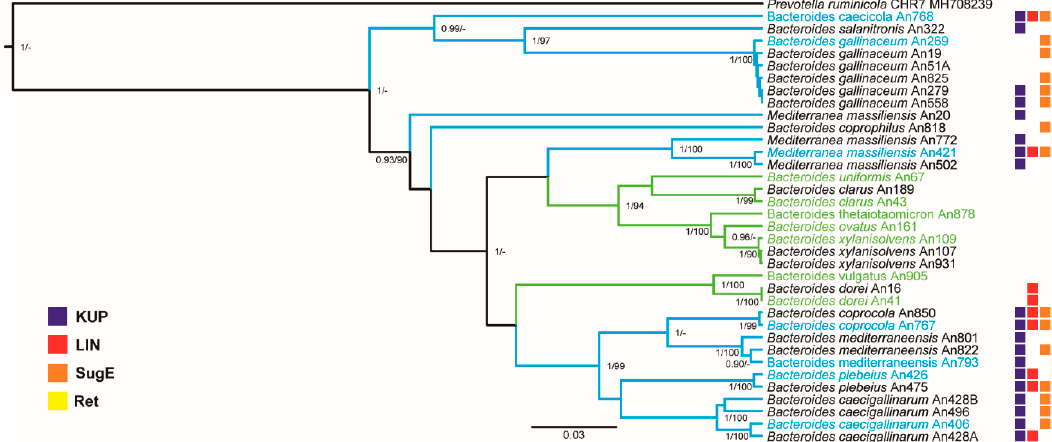
Figure 2. A phylogenetic reconstruction of 35 Bacteroidaceae isolates based on 16S rRNA sequence using Bayesian inference. Supports at the nodes represent Bayesian inference and maximum likelihood, respectively. Only posterior probabilities >0.90 and bootstrap values >90 are shown. Clades in blue or green represent chicken- or human-adapted Bacteriodes species, respectively. Isolates in blue represent chicken-adapted species selected for genomic comparisons with human isolates. Isolates in green represent human-adapted species selected for genomic comparisons with chicken isolates. Presence of kup , linA , sugE and ret genes in each genome is shown by blue, red, green and yellow squares, respectively. For alternative alignment using rpoB nucleotide sequence see Figure S1.